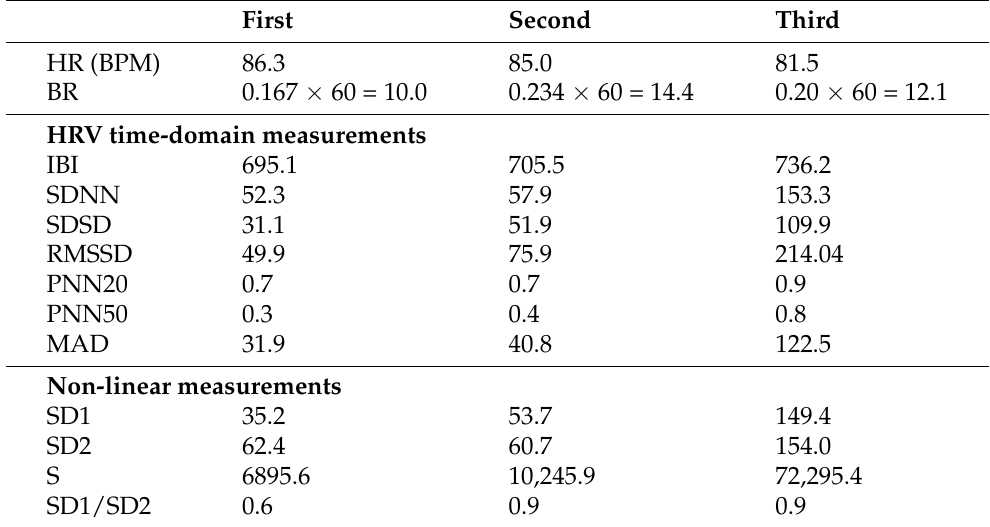
Table 2. Values of the extracted parameter with HeartPy for all three